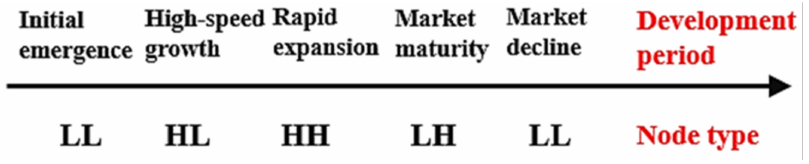
Figure 2. Type and period classification of node cities 2